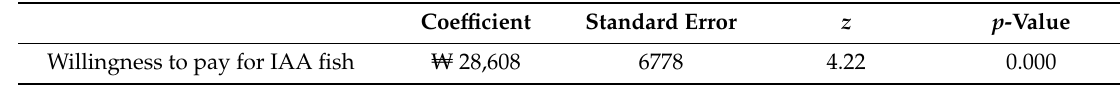
Table 8. Willingness to pay for IAA fish